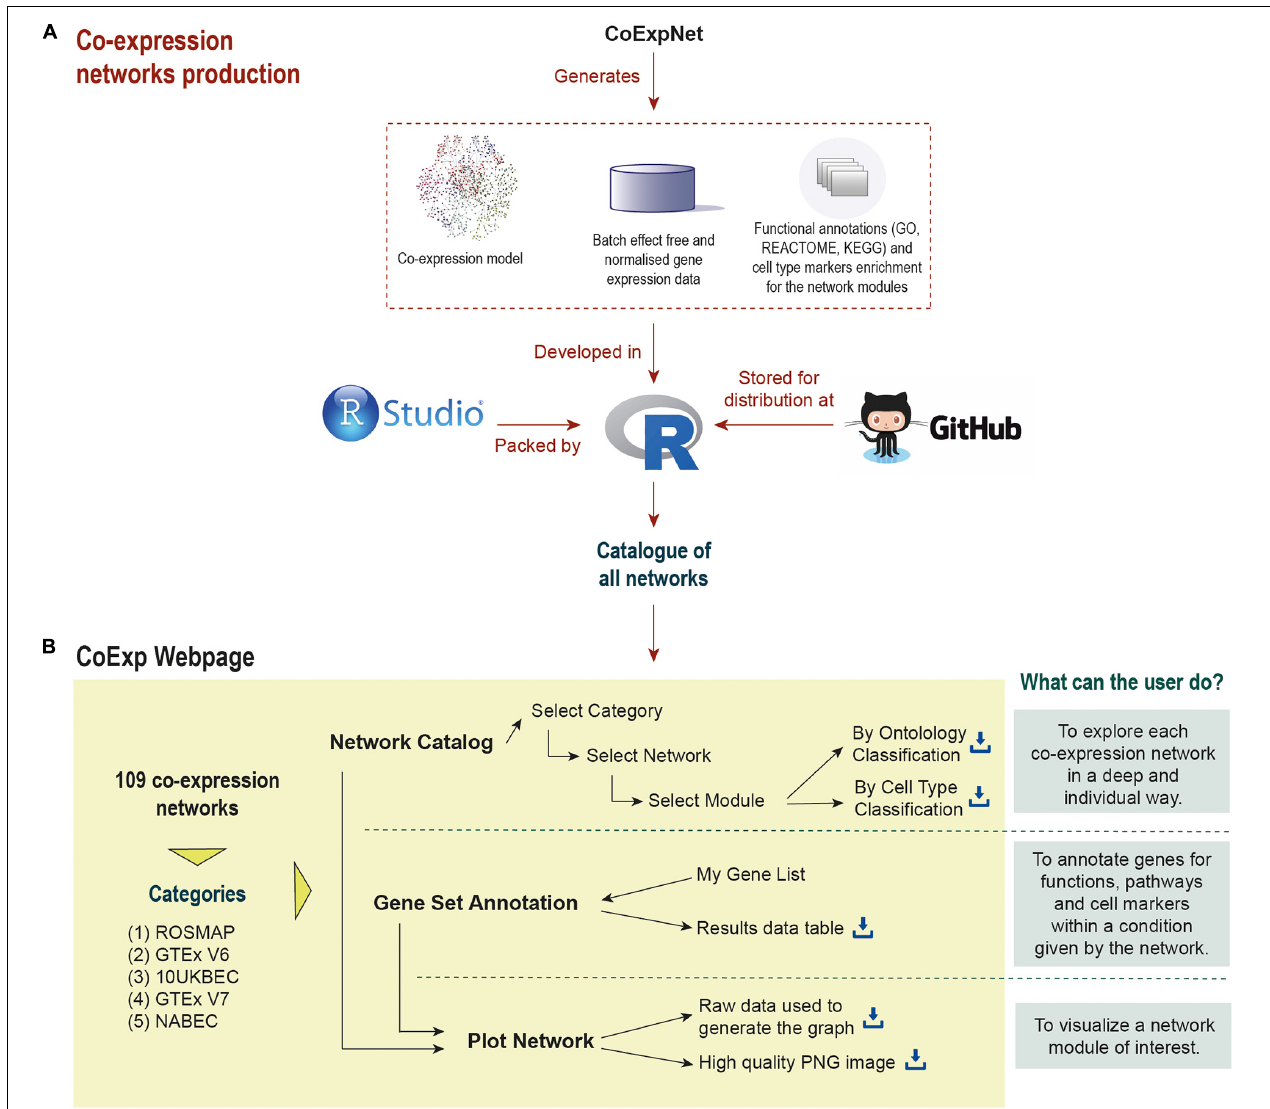
FIGURE 1 | Life cycle of a co-expression model in CoExp: (A) the network is built from an expression profiling data set using the CoExpNets package. This generates a network, a set of residuals as a result of data QC processes and annotations for gene module function and cellular specificity. All networks are integrated into R packages (with a package for each category, namely ROSMAP, GTEx V6 and V7, UKBEC, and NABEC). These are made available within GitHub (see the links at the “Availability and Implementation” section of this paper). The packages are then integrated into the Web application (B) . There they can be exploited and